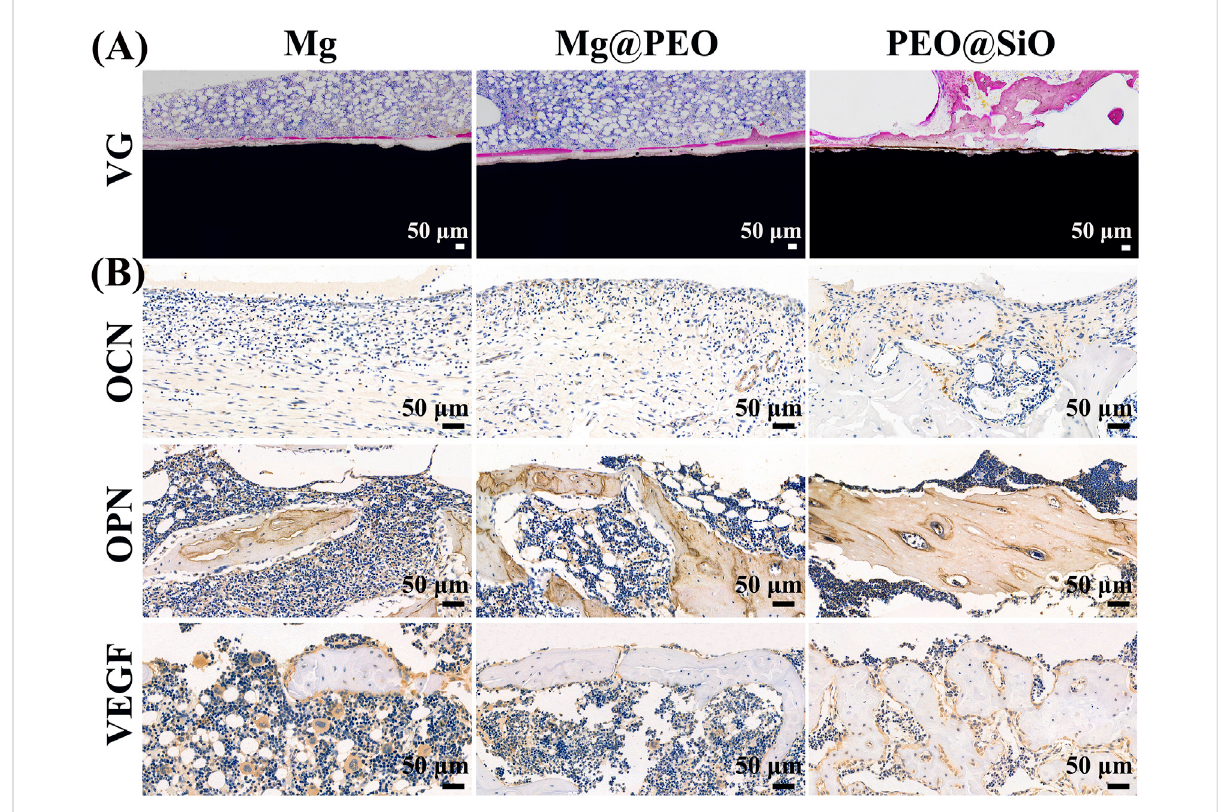
FIGURE 8 Osseointegration ability of different implants after implantation for 3 months: (A) VG staining of tissues surrounding the various samples after femur implantation. (B) Immuno-histological staining of OCN, OPN, and VEGF protein of decalci fi ed femurs around different